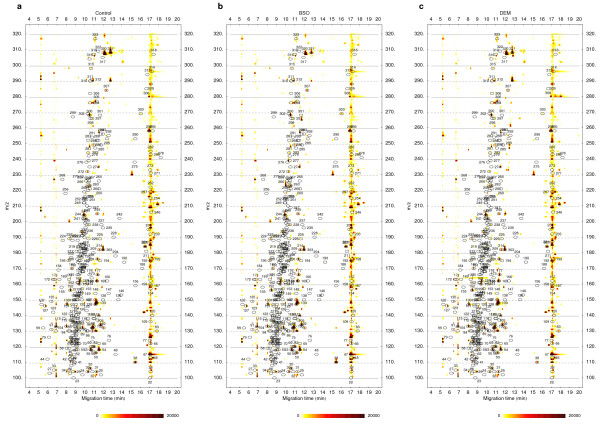
Metabolite profiles for the three-way comparison. Mouse liver extract metabolite profiles acquired by CE-TOFMS two hours after intraperitoneal injection with (a) vehicle (Control), (b) diethylmaleate (DEM), a non-protein thiol-depleting chemical, or (c) buthionine sulfoximine (BSO), an inhibitor of γ-glutamylcysteine synthase. The plotted datasets are averages of five normalized replicate datasets for cation measurements originating from our previous work [2]. The averaged datasets are visualized as density plots. For all plots, numbered ovals (annotation labels) indicate the expected locations of peaks of a set of known chemical compounds and are used for identification of metabolites on the density plots [2,3].